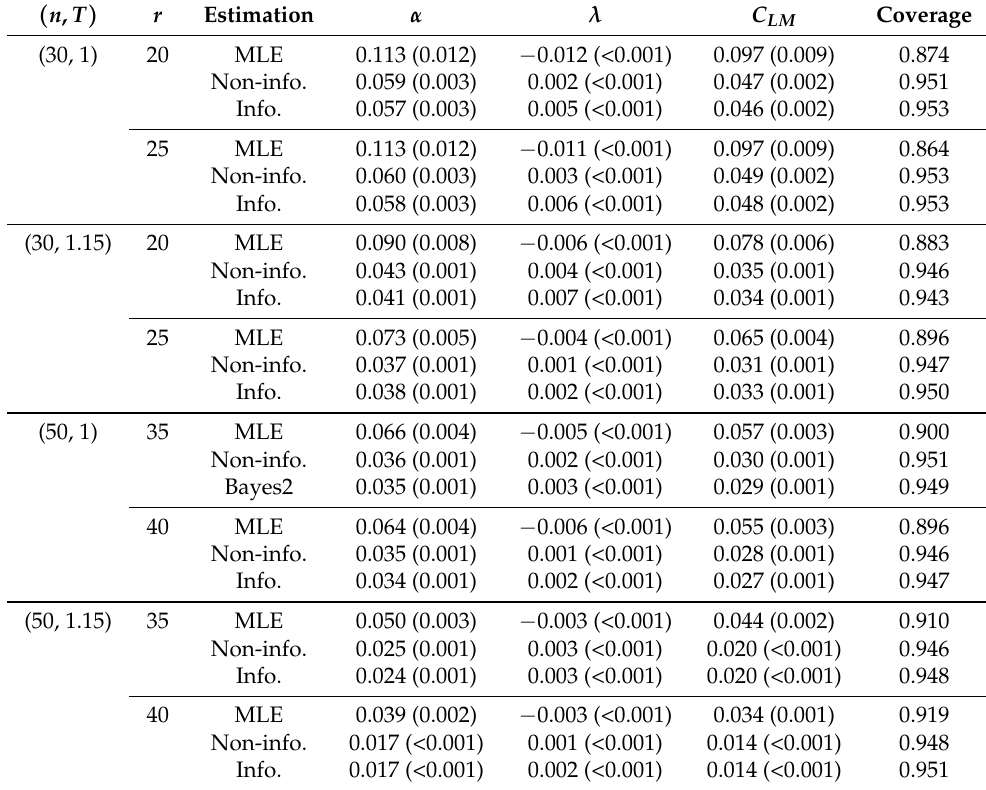
Table 2. The rBias and rMSE (in parentheses) for ( α , λ ) = ( 5, 1 ) and L =